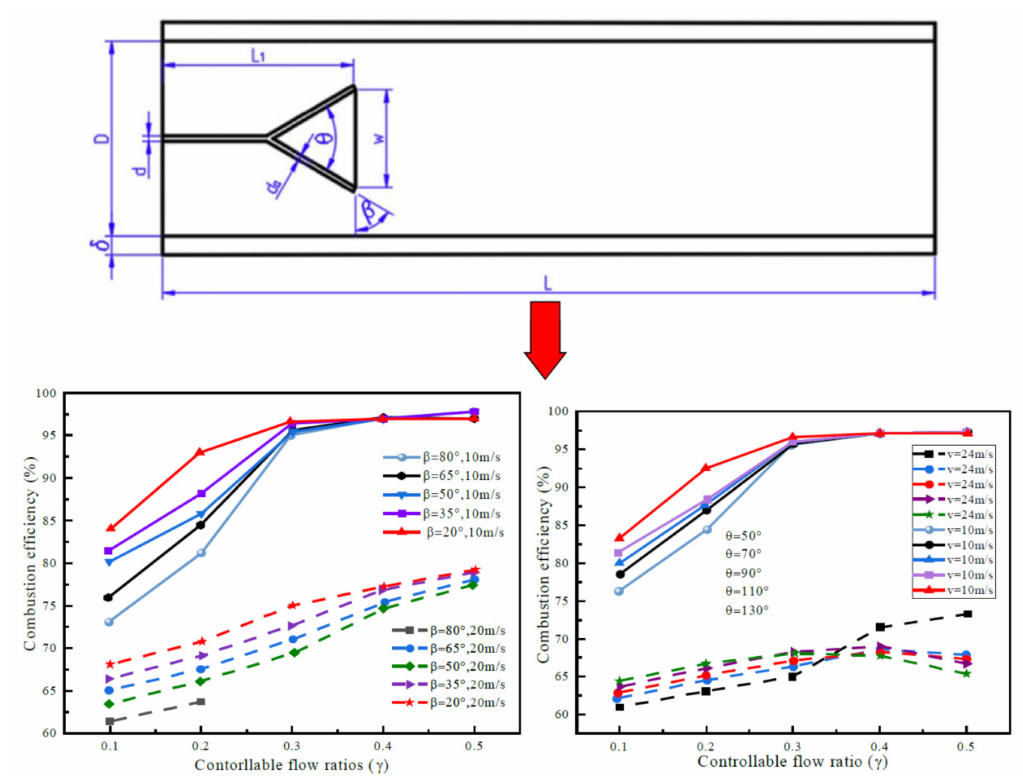
Figure 20. Effect of the controllable flow angle on combustion